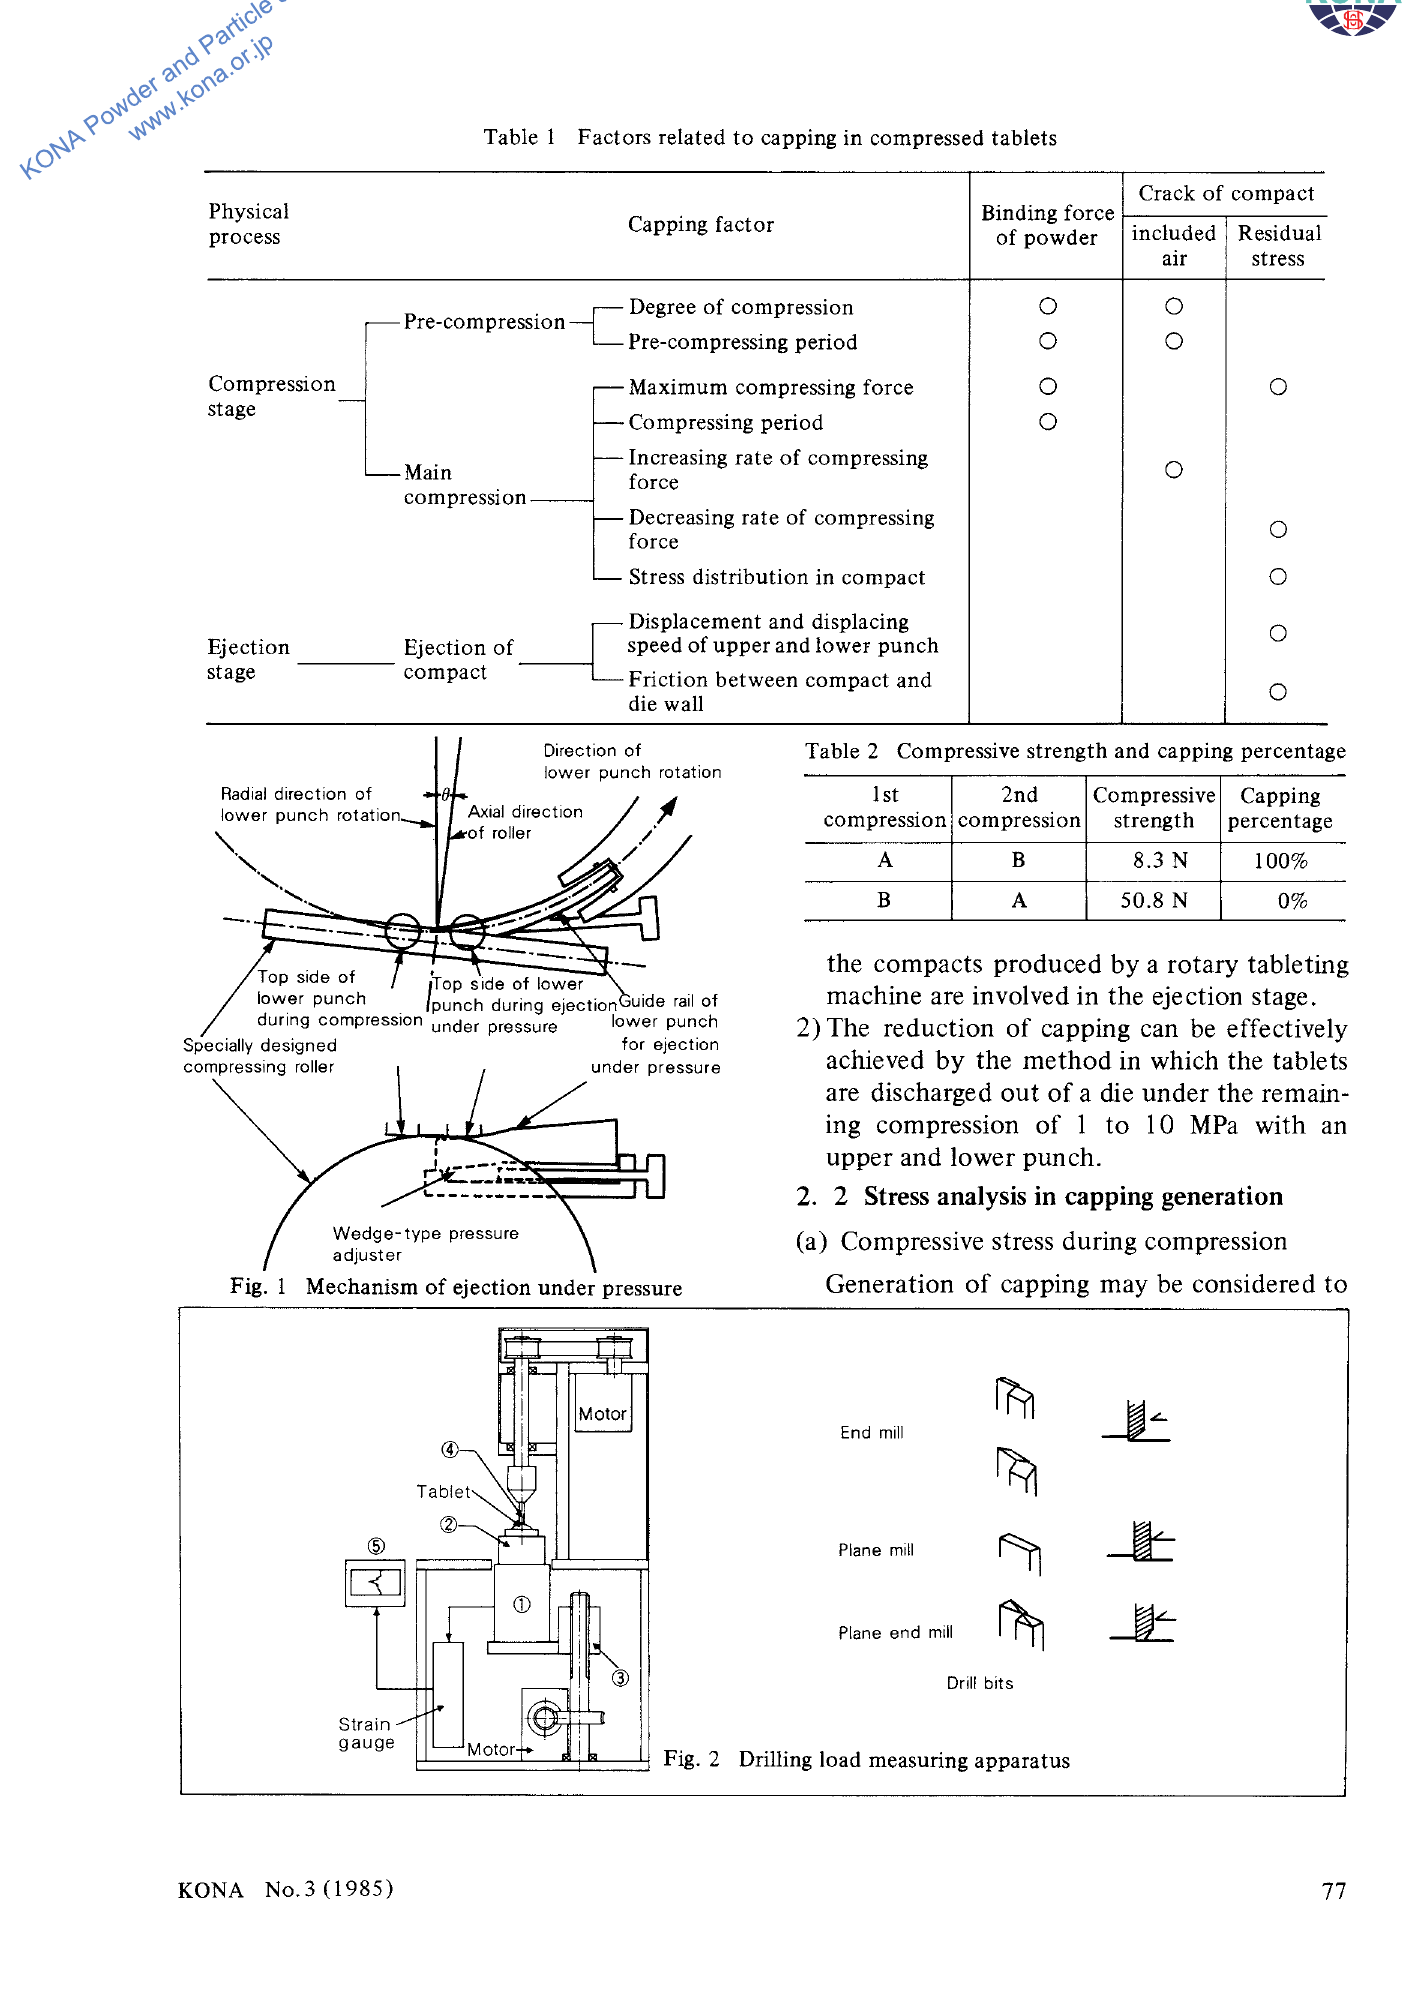
Fig. 1 Mechanism of ejection under pressure